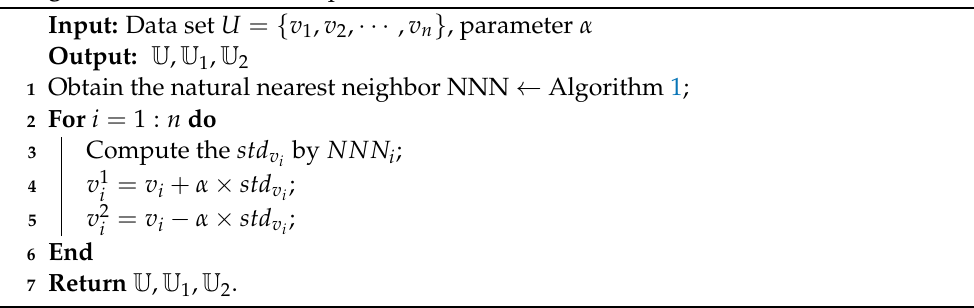
Algorithm 2: Generation of perturbed data